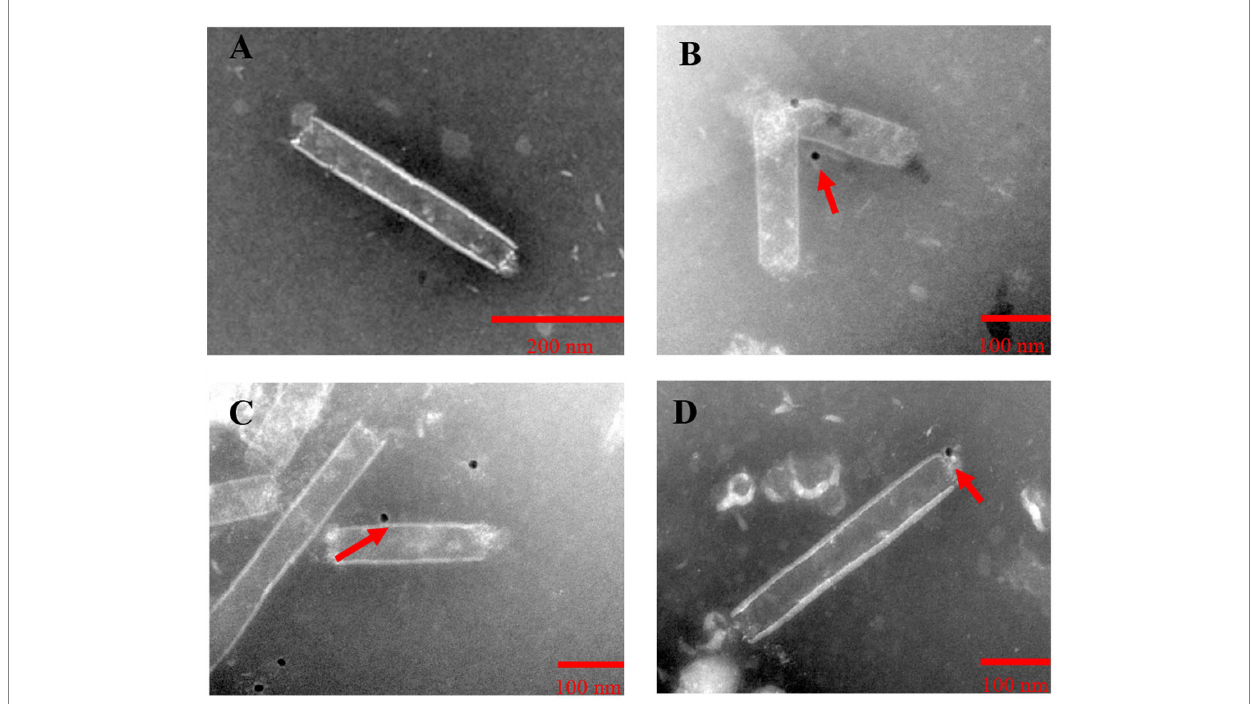
FIGURE 5 Immunoelectron microscopic observation of purified recombinant baculoviruses. (A) rvAc-dual was incubated with mCherry monoclonal antibodies. (B) rvAc-Gn-mCherry was incubated with mCherry monoclonal antibodies. (C) rvAc-Np-eGFP was incubated with eGFP monoclonal antibodies. (D) rvAc-Gn-mCherry-Np-eGFP was incubated with eGFP monoclonal antibodies. On the surface of the recombinant baculovirus incubated with mCherry and eGFP monoclonal antibodies, colloidal gold particles with a diameter of approximately 10 nm aggregated in the vesicle region, whereas no colloidal gold particles were found on the surface of wild-type baculovirus.